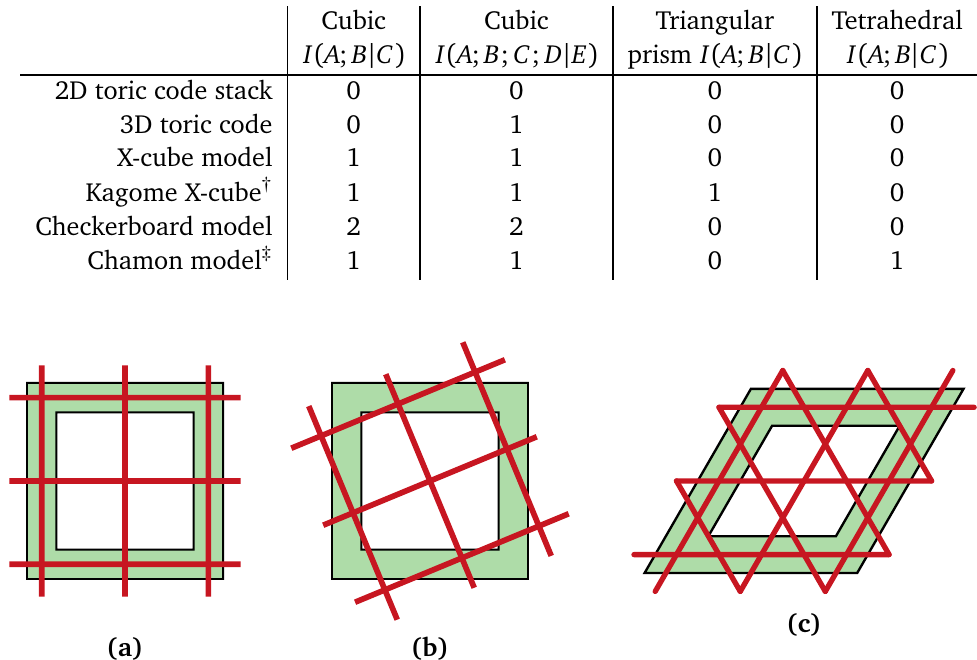
Table 1: Entanglement quantities for the wireframe schemes discussed (Fig. 3). Logarithms (in Eq. (6)) are calculated in base 2. Models are reviewed in Appendix B.